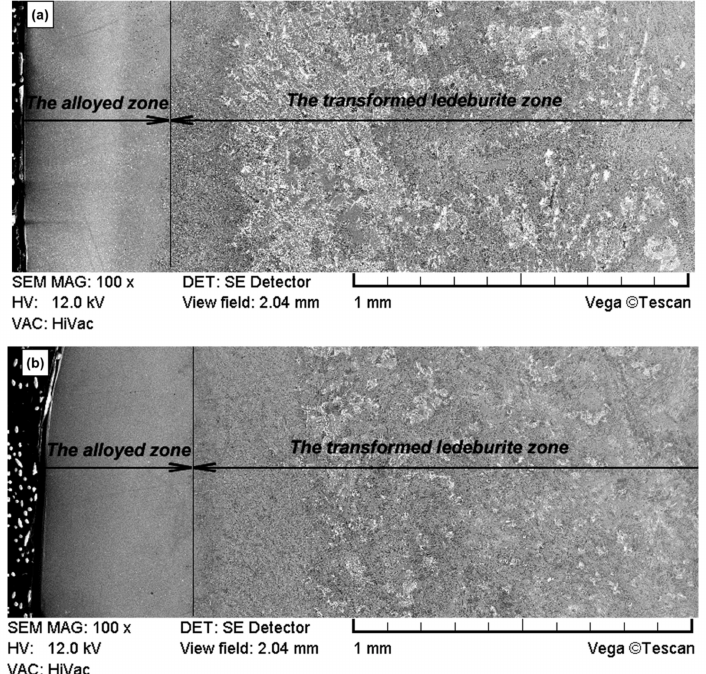
Figure 7. Microstructure of the surface layer after laser implementation of nickel ( a ) and a combination of nickel and chromium ( b ) (scanning electron microscope, etched with nitric